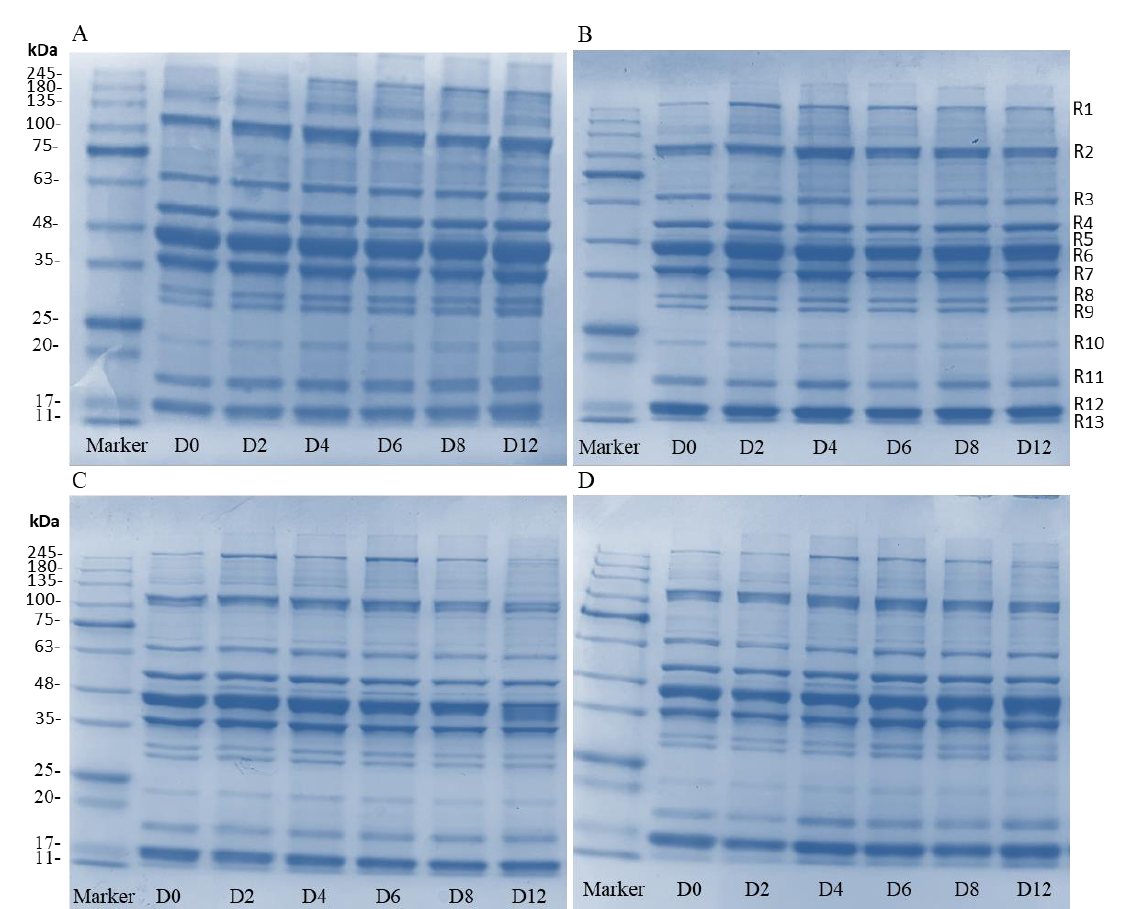
Figure 7. The SDS-PAGE analysis of control samples ( A ), H samples ( B ), HP-15 samples ( C ), and HP-10 samples ( D ) (CK: control; H: 2% sodium alginate + antibacterial agents; HP-10: 2% sodium alginate + antibacterial agents + 1:10 protein solution; HP-15: 2% sodium alginate + antibacterial agents + 1:15 protein solution). D0 to D12 represent storage on days 0 to 12.